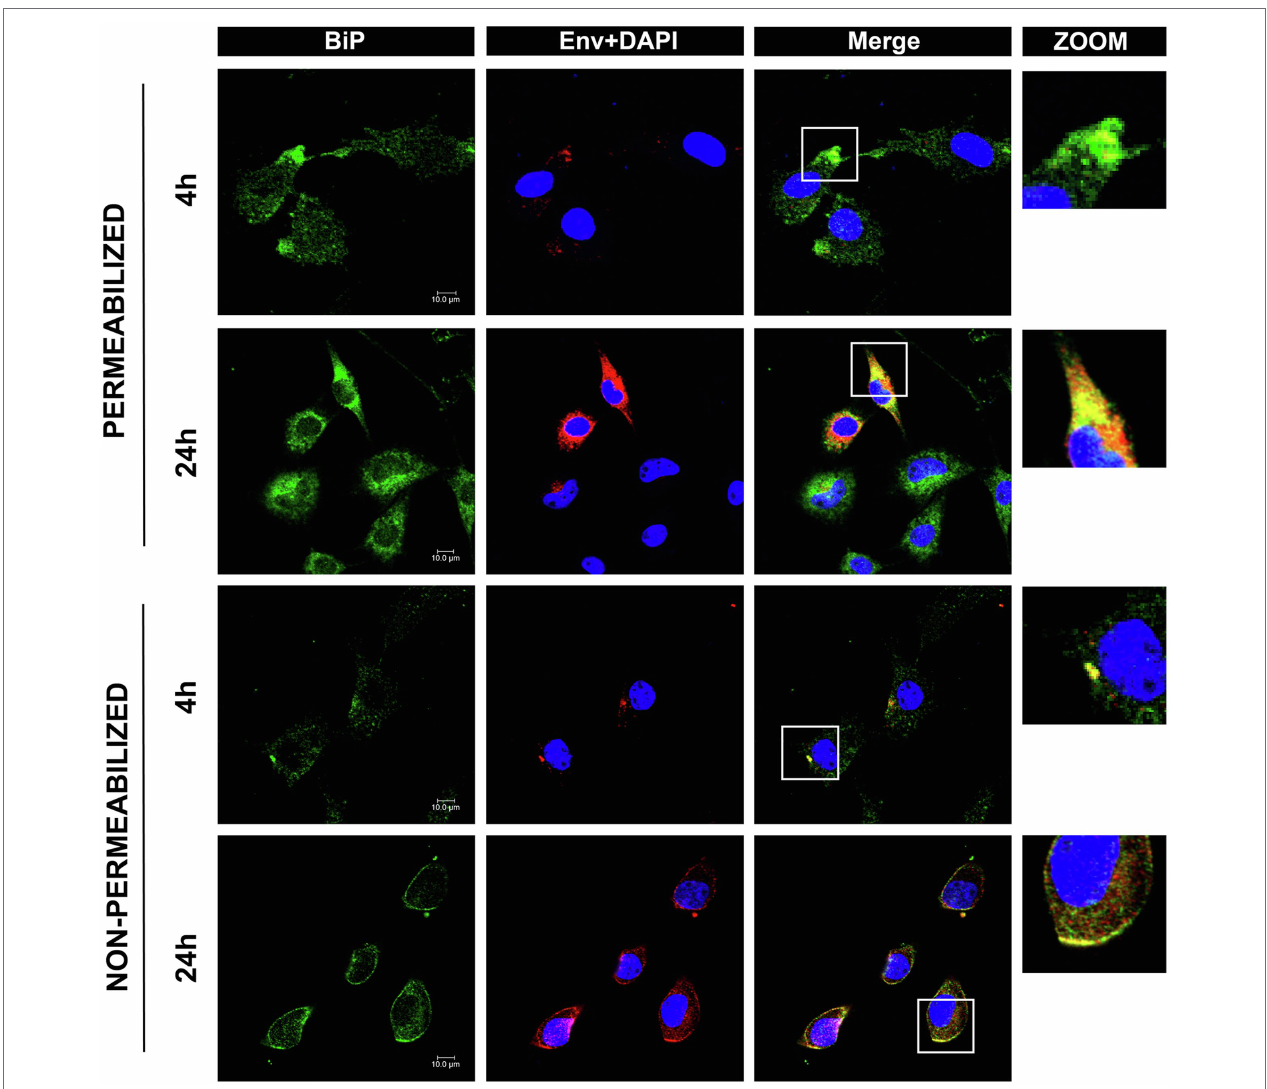
FIGURE 5 | Confocal immunofluorescence shows BiP interactions with ALV-J Env protein. DF-1 cells grown on glass coverslips were infected with ALV-J at an MOI of 5 for the indicated time. The cells were fixed, permeabilized, or non-permeabilized, followed by immunofluorescence labeling of BiP (green) and ALV-J Env (red). DAPI (blue) indicates nuclear staining. Yellow indicates colocalization (scale bars, 10 μ